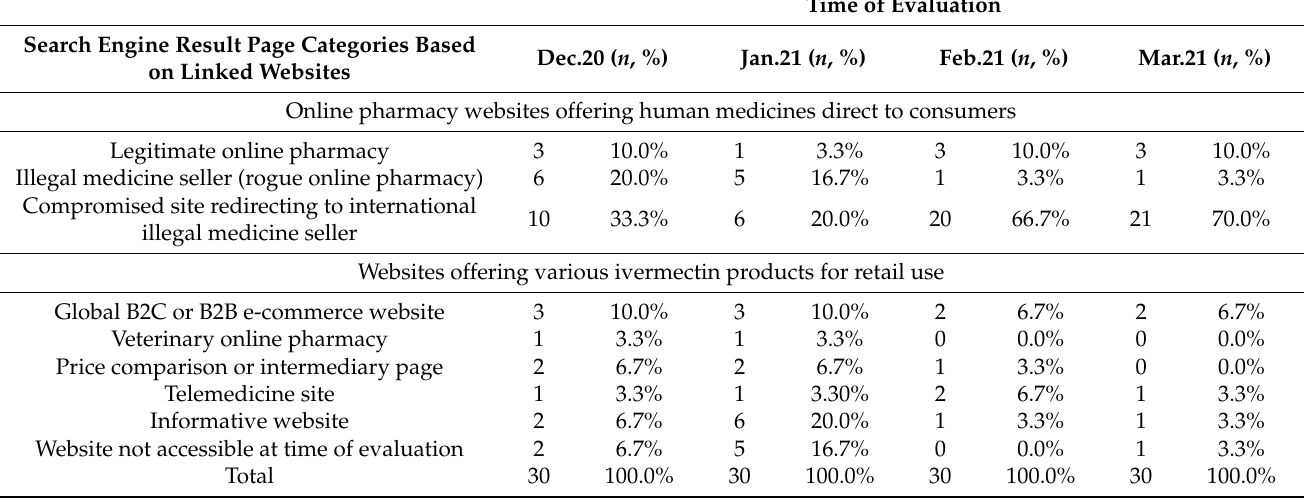
Table 1. Probability of occurrence of website categories of organic links among first thirty search engine results for “buy ivermectin online” search